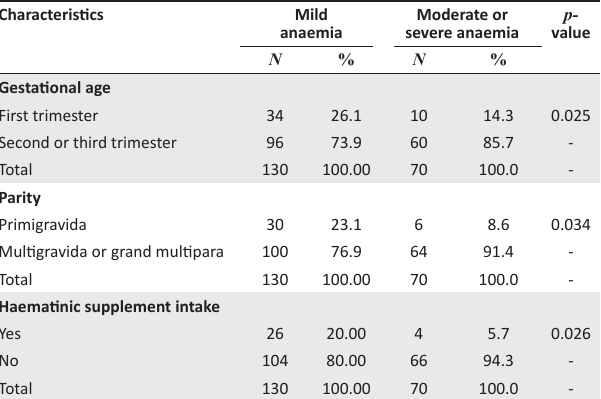
TABLE 4: Differences in the degree of anaemia with gestational age, parity and haematinic supplement intake, Sudan, September 2016 to February 2017.